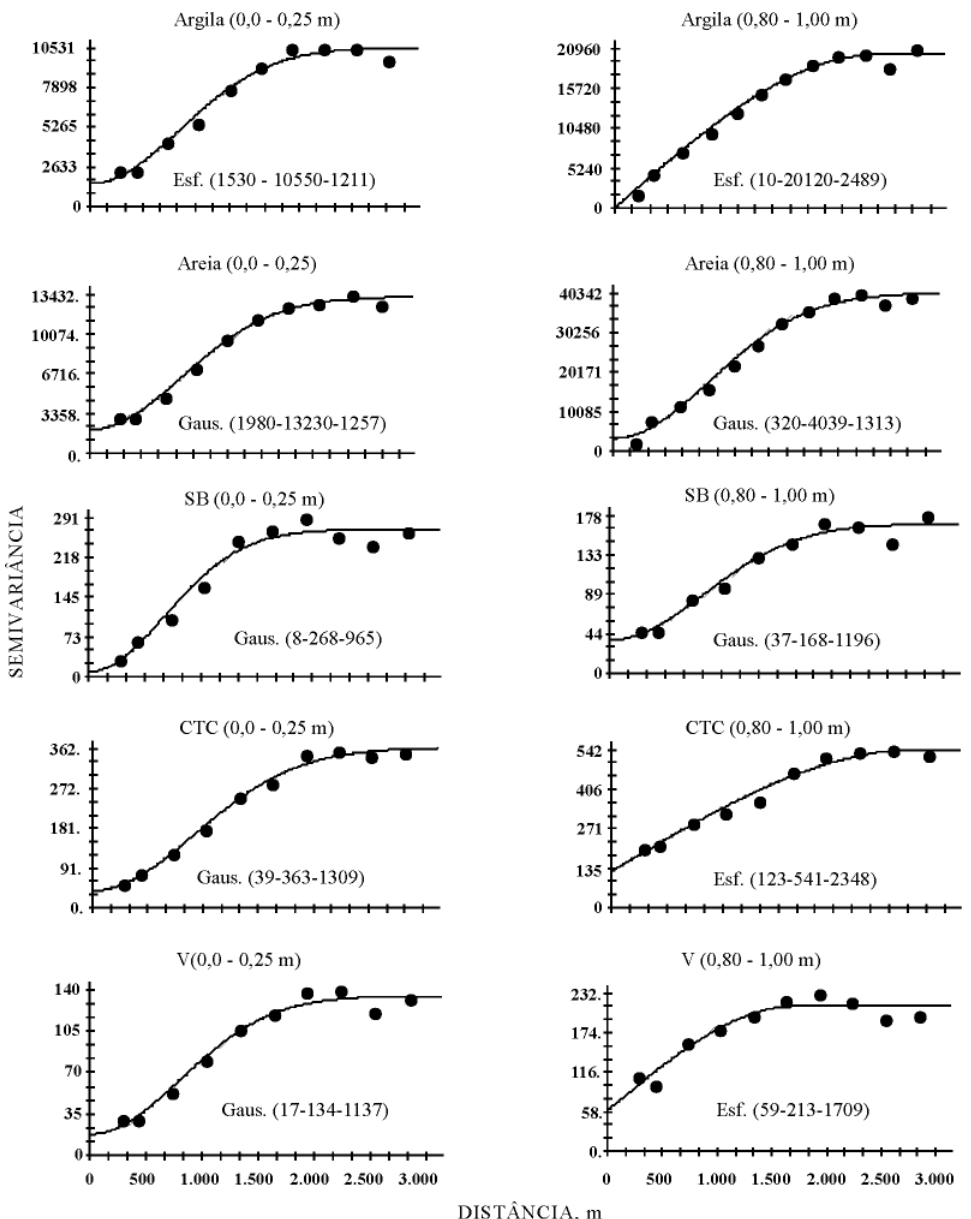
Figura 3. Semivariograma do conteúdo de areia e argila (g kg -1 ), soma de bases (SB), capacidade de troca catiônica (CTC) (mmol C + C ; a) Esf = modelo esférico; Gaus = modelo gaussiano; C 1 0